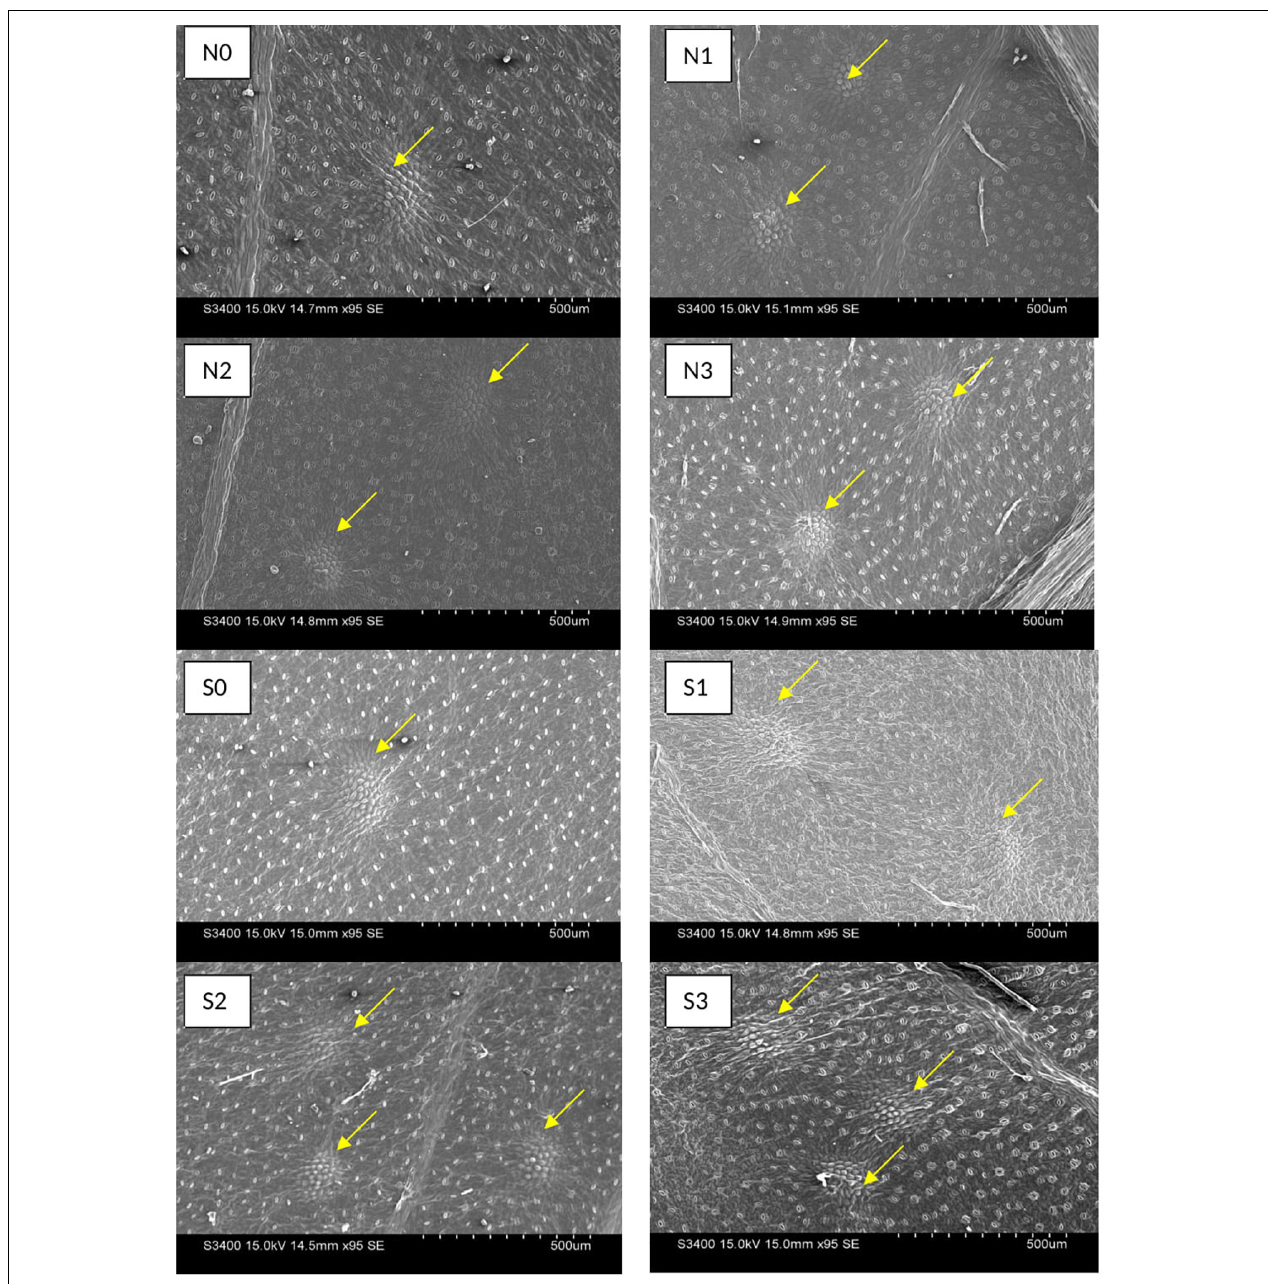
FIGURE 5 | Effect of nitrogen (N) and sulfur (S) fertilization levels on leaf oil glands characteristics. N0, N1, N2, and N3 are the level of nitrogen @ 0, 60, 90, and 120 kg ha - 1 , respectively, while S0, S1, S2, and S3 are representing the level of sulfur @ 0, 20, 40, and 60 kg ha - 1 ,